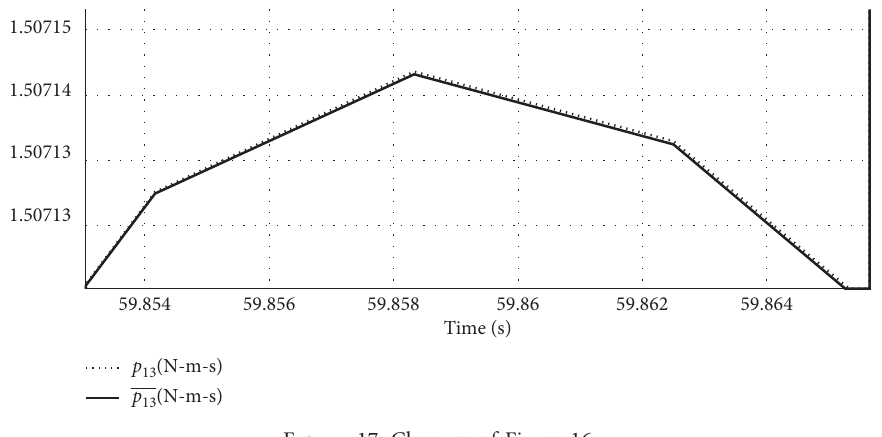
Figure 17: Close up of Figure